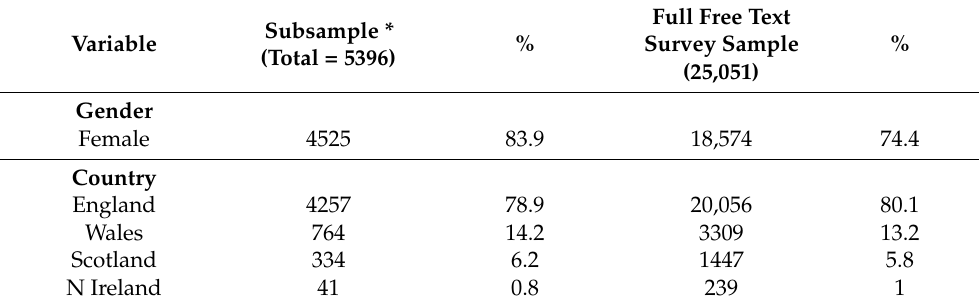
Table 3. Demographic information of those who participated in data collection containing the free-text module (full sample) and those who mentioned physical activity within quotes